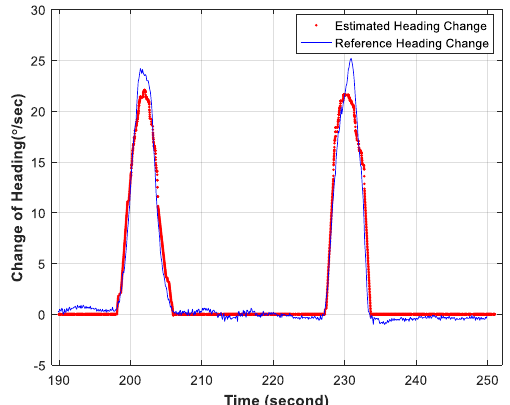
Figure 14. The estimated change of heading versus the reference change of heading for the right turns category.